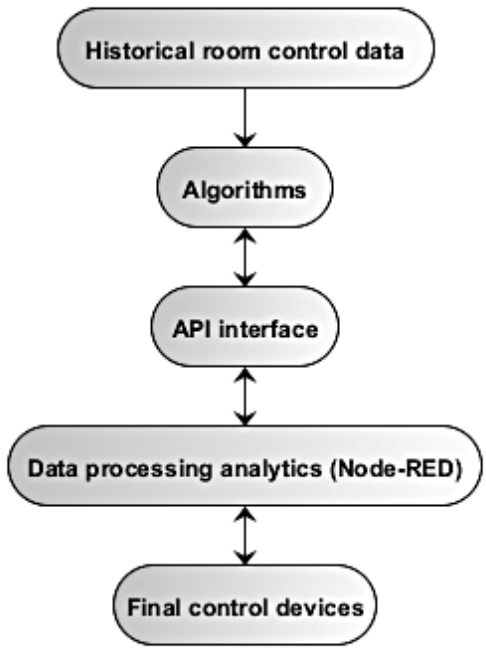
Figure 18. Prediction and control of end devices.